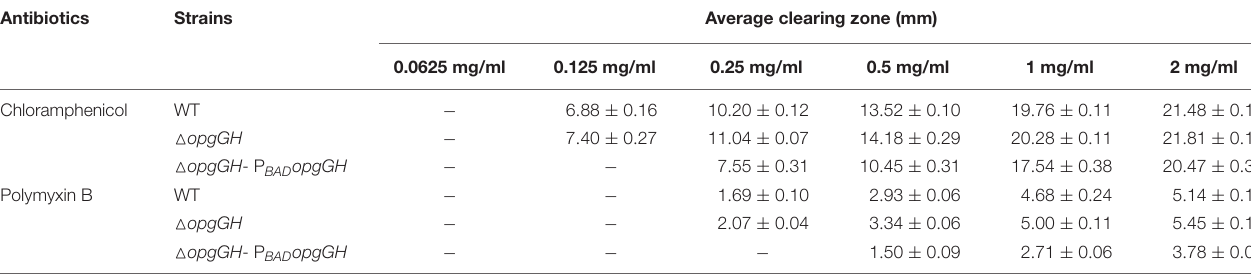
TABLE 2 | Susceptibility of Y. enterocolitica strains to chloramphenicol and polymyxin B. Antibiotics Strains